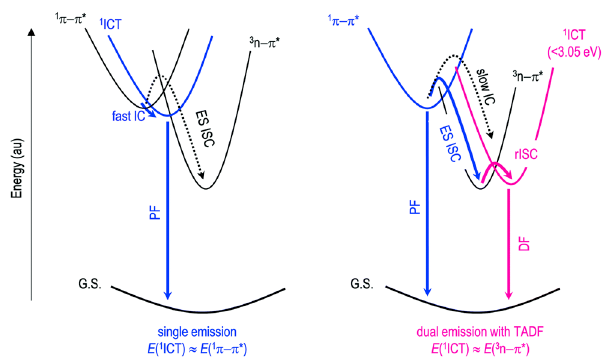
Figure 29. Mechanism proposed for the single Kasha D-coumarin derivatives ( left ) and dual anti- Kasha emission ( right ) from 105 , 106 and 107 . Abbreviations: G.S., ground state; ES ISC, El-Sayed- rule-allowed ISC; PF, prompt fluorescence; DF, delayed fluorescence. Adapted from [87], Copyright 2021, with permission from the Royal Society of